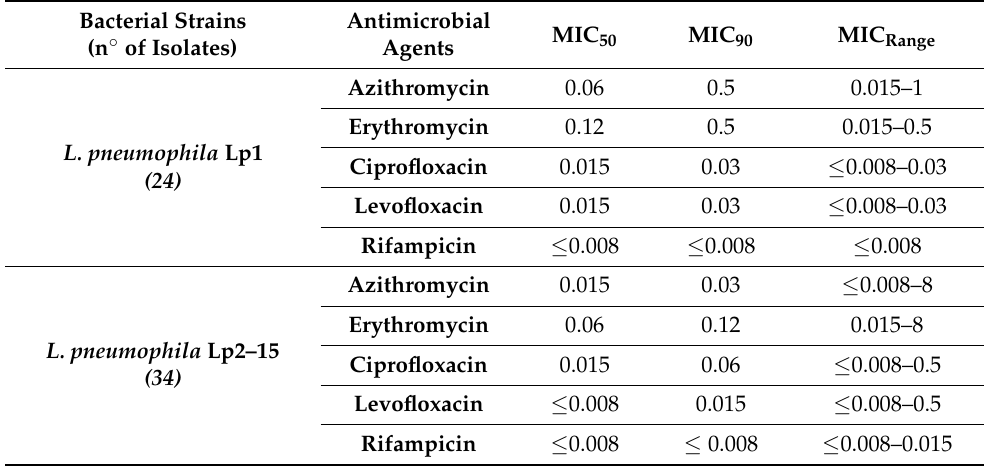
Table 3. MIC Range , MIC 50 , and MIC 90 values (mg/L) of Legionella pneumophila serogroup 1 (Lp1) isolates compared with serogroup 2–15